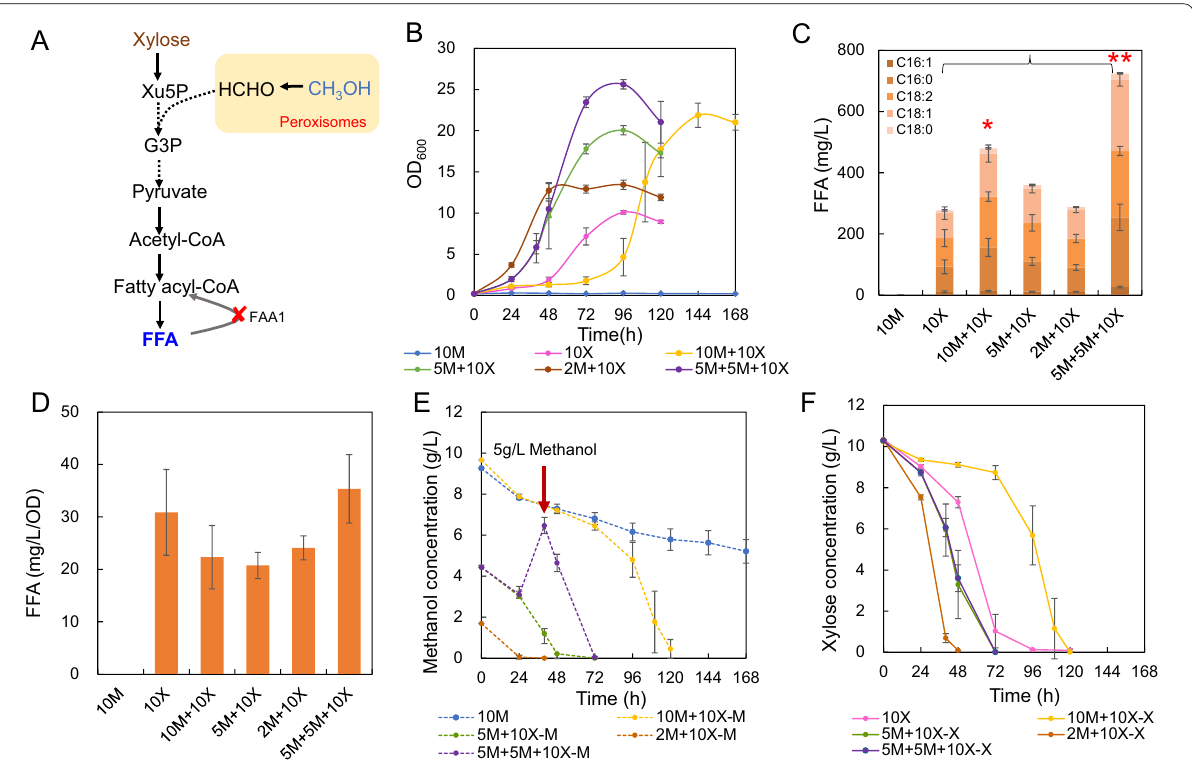
Fig. 5 Co-feed of xylose and methanol for FFA production in strain FD09. A Schematic diagram of xylose and methanol metabolism in O. polymorpha . Supplemented xylose will increase Xu5P supply via xylose metabolism for both cell growth and FFA production. B Growth curves of strain FD09 in different carbon sources. 10 M: 10 g/L methanol, 10X: 10 g/L xylose, 10 M/5 M/2 M 5 M 5 M 10X: Initial adding 5 g/L methanol and 10 g/L xylose and then supplementing 5 g/L methanol at 48 h. C FFA titers of strains cultivated + + in minimal media containing above substrates. Red asterisks indicate statistical significance as determined by paired t test (*P < 0.05; **P < 0.01). D Specific FFA production rate of strains cultivated in minimal media containing above substrates. E Methanol concentration. F Xylose concentration. Data are presented as mean s.e.m. (n 4 biologically independent ± =